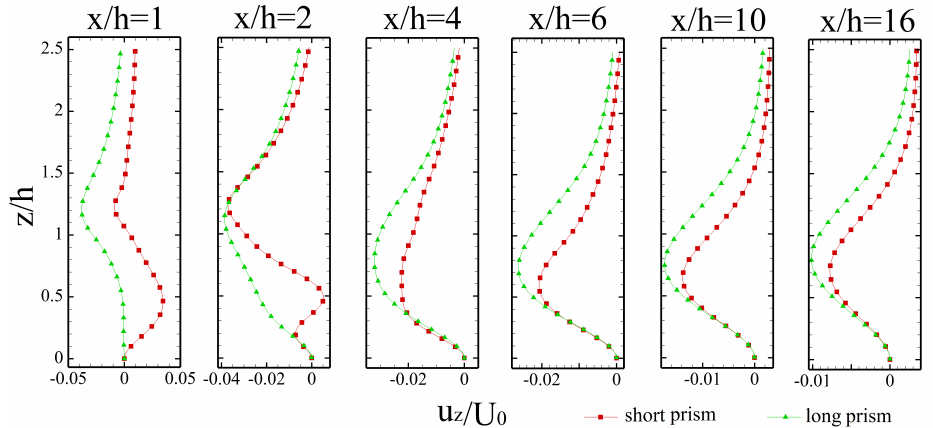
Figure 23. The profiles of spanwise velocity ( u z ) in the symmetry plane of both prisms at different distances (identified as ‘ d ’) from the rear face of the prism at Re = 250.